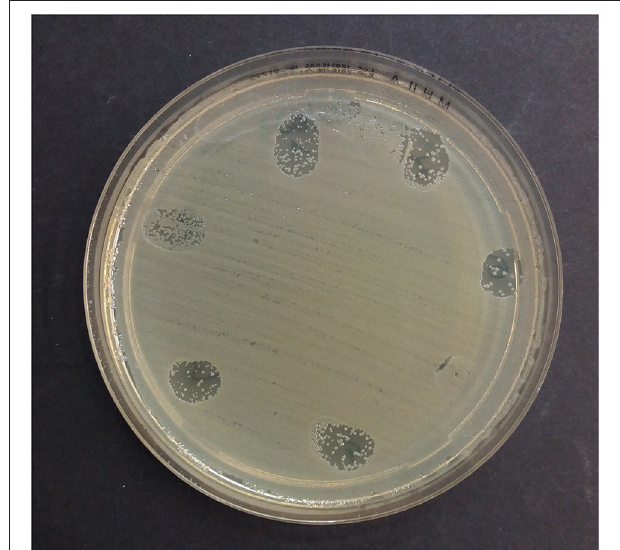
FIGURE 4 | Leukocyte-formulations against the extensively resistant E. coli after 18h at 37 ◦ C aerobically. 1: platelet lysate; 2: thrombin; 3: L-PRP; 4: L-PRP plus thrombin; 5: L-PRP plus calcium gluconate; 6: L-PPP; 7: